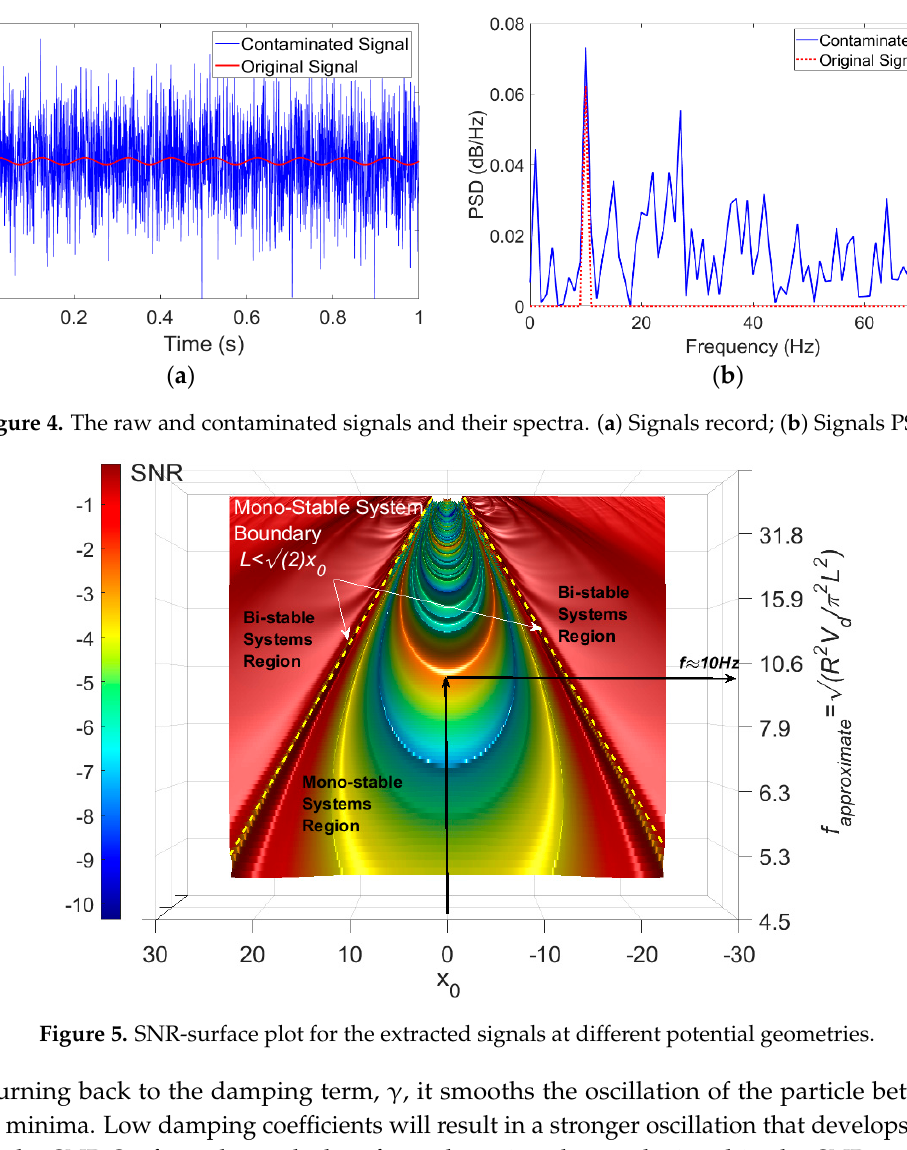
Figure 6. FI-UPSR results ( a ) SNR surface plot, ( b ) extracted weak signal, and ( c ) PSD plot for the extracted signal.